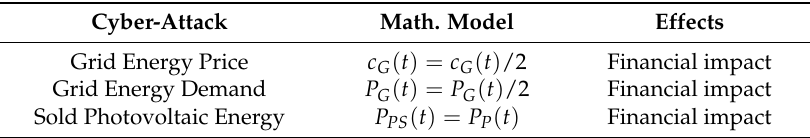
Table 4. Mathematical model for the simulation of integrity attacks.